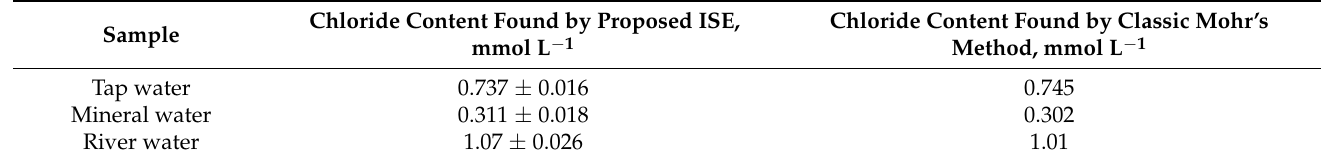
Table 6. Determination of chlorides in water samples by direct potentiometry and comparison with the classic Mohr’s